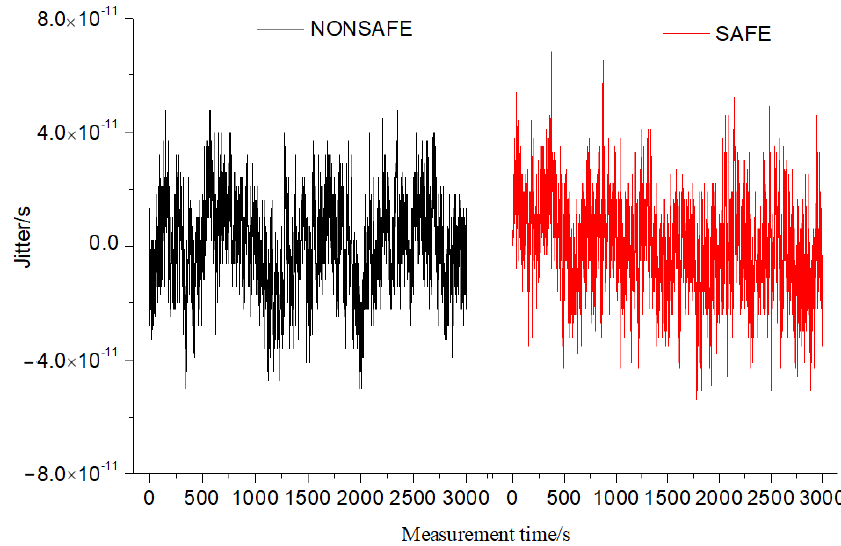
Figure 6. Comparison of delay jitter data of single equipment.